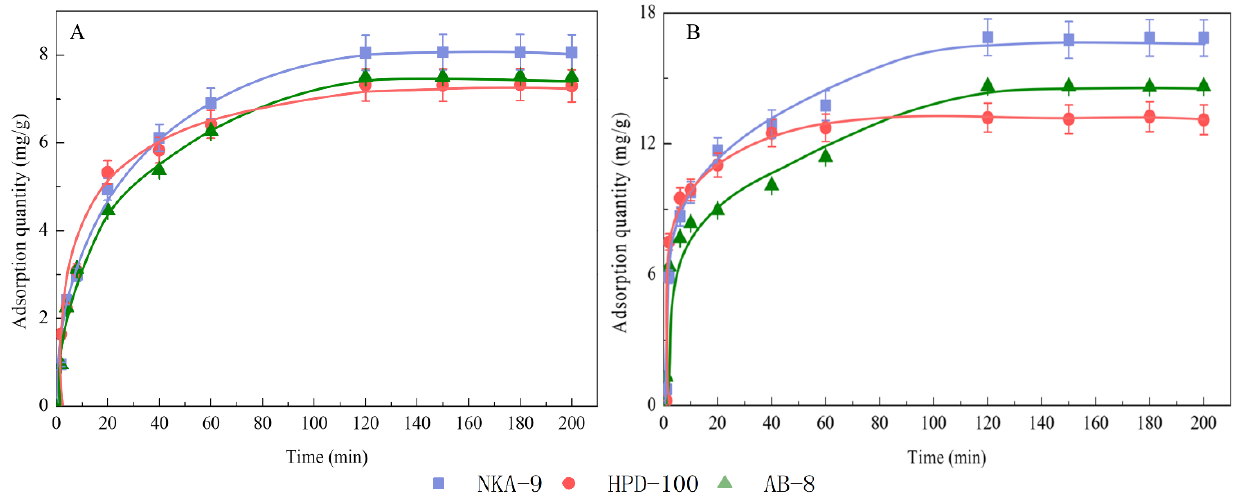
Figure 5. Static adsorption kinetics curve of polyphyllin II ( A ) and polyphyllin VII ( B ) on NKA-9, HPD-100, and AB-8 resins.